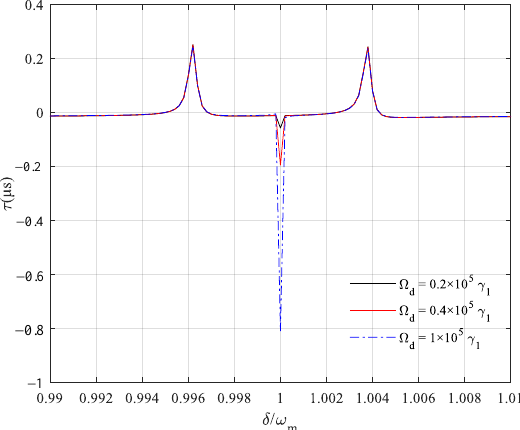
 for different values of Figure 7. Group delay τ as a function of the probe detuning δ / ω m for different values of driv- Figure 7. Group delay  as a function of the probe detuning m ing strength Ω d . Ω d = 0.2 × 10 5 γ 1 (black, solid curve); Ω d = 0.4 × 10 5 γ 1 (red, dashed curve);  . 5 0.2 10  =  (black, solid curve); 5 0.4 10  =  (red, dashed curve); driving strength d 1 d 1 d Ω = 1 × 10 5 γ = 5 × 10 − 9 γ 5 1 10  =  (blue, dash-dotted curve), 9 5 10   − =  , and the other parameter values are the 1 (blue, dash-dotted curve), χ 1 , and the other parameter values are the d 1 d 1 same as in Figure same as in Figure 5.